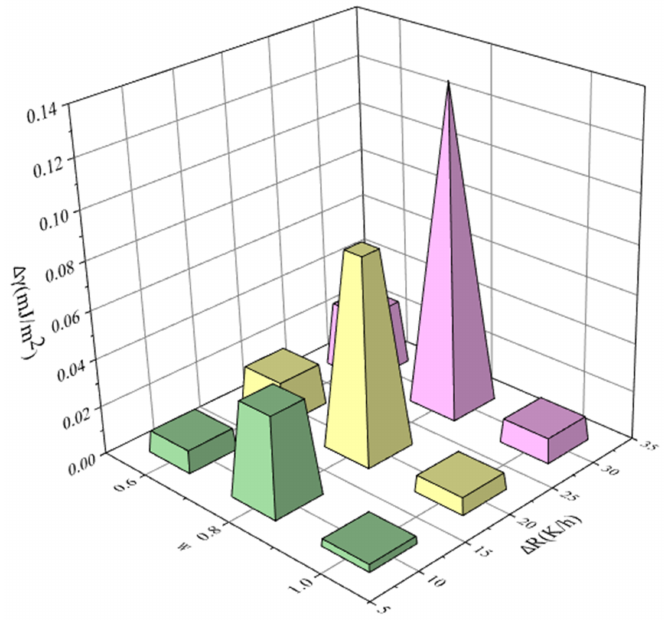
Figure 17. The relationship between interfacial energy and the change in cooling rate (saturated temperature 303.15 K, ethanol mass fraction 0.6, 0.8, and 1.0,